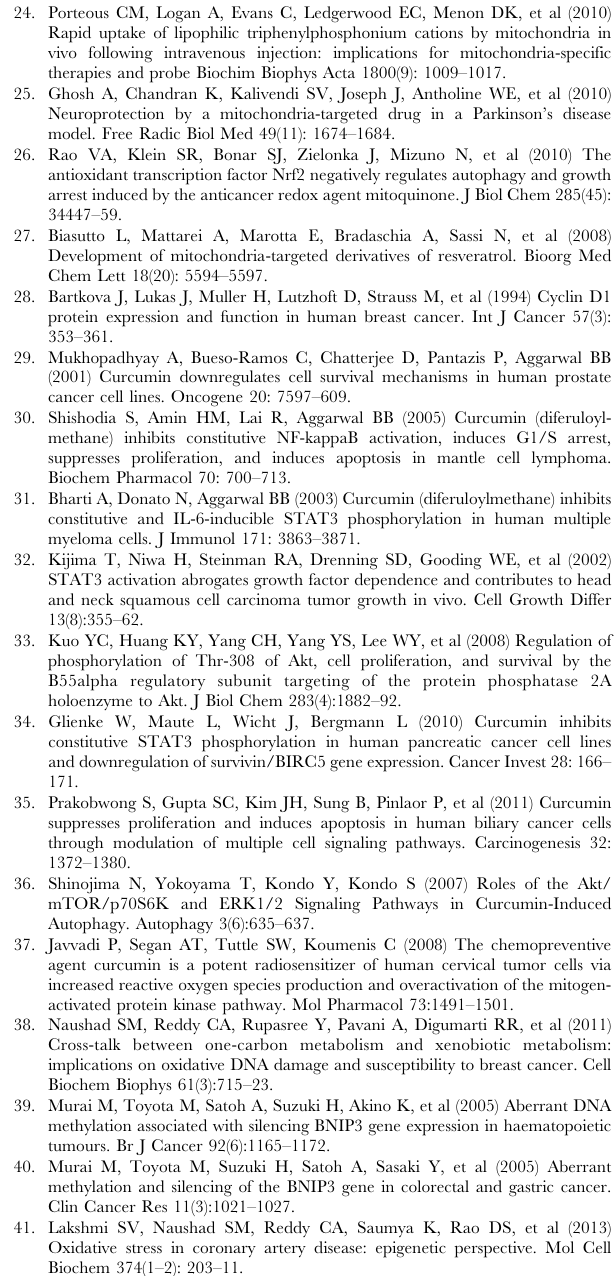
of TPP + for 24 h. At the end of treatments, cell viability was assayed by SRB